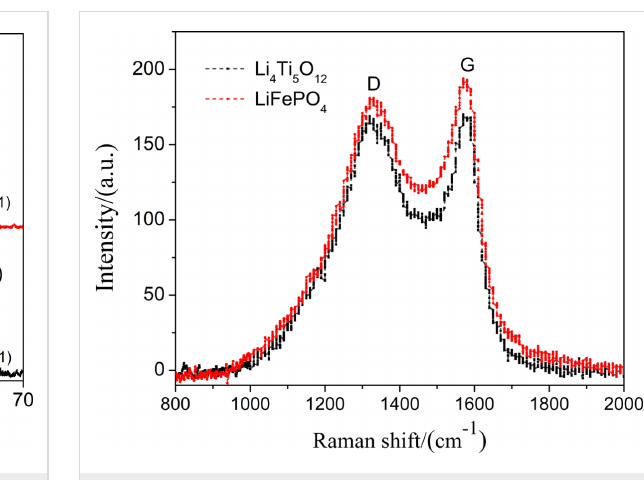
Figure 5: XRD patterns of LiFePO 4 and Li 4 Ti 5 O 12 fiber membranes.